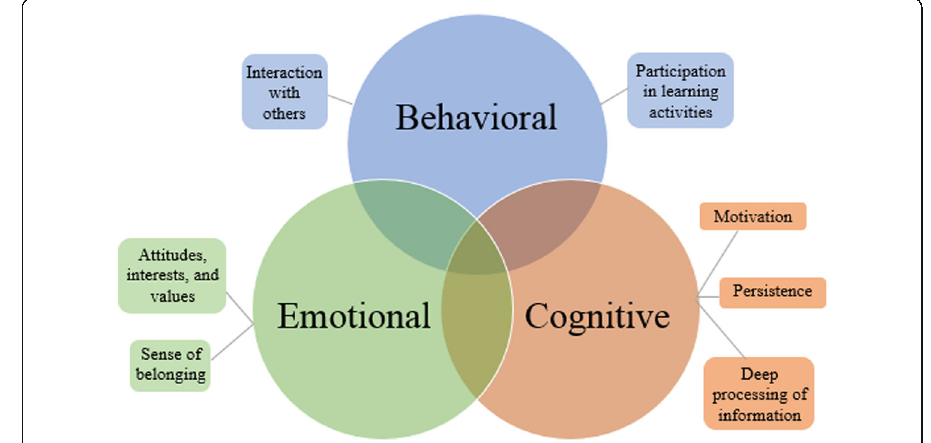
Fig. 1 Conceptual framework of types and indicators of student